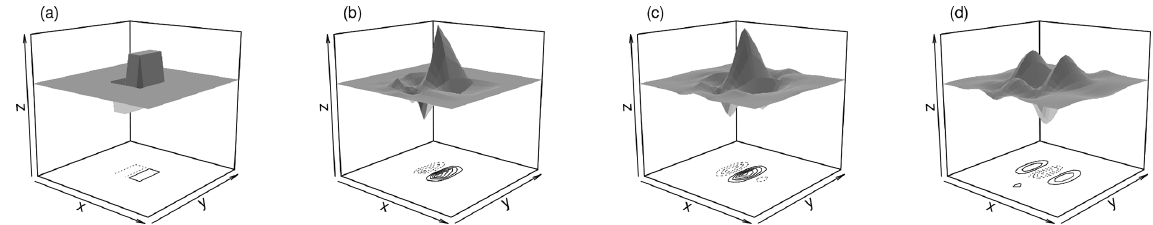
Figure 2. Two-dimensional Daubechies daughter wavelets D 1 and D 2 (a, b) , as well as least asymmetric D 4 (c) and D 8 (d) , vertical